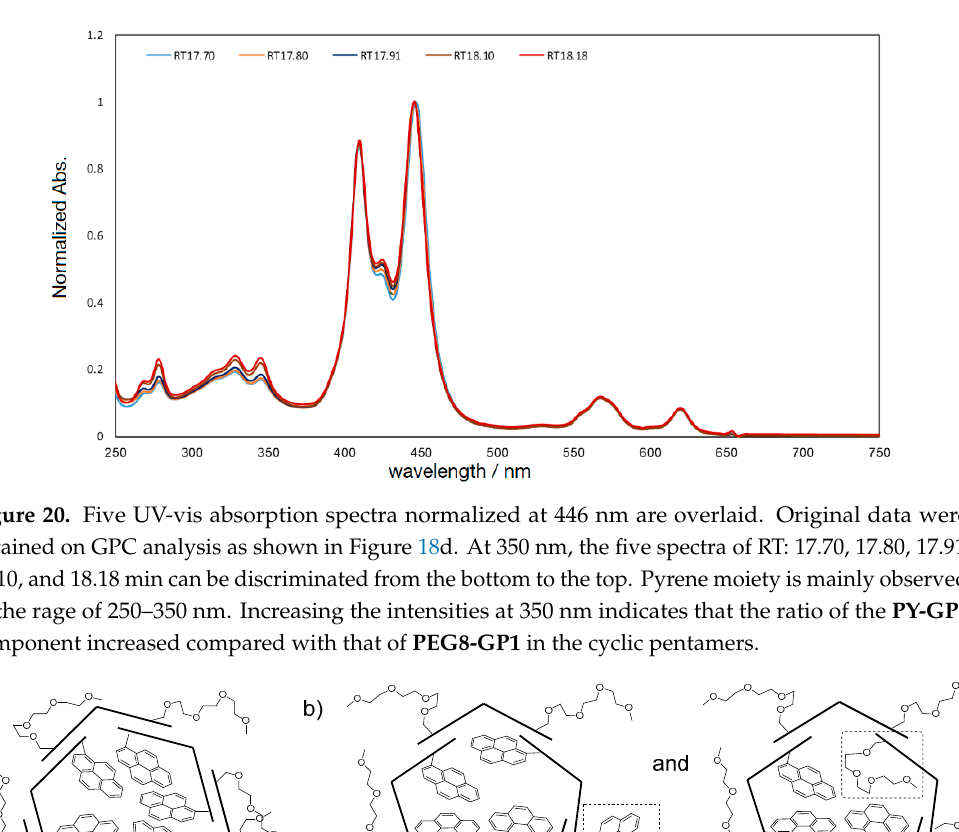
Figure 19. ( a ) UV-vis spectra of PY-GP1 and PEG8-GP1 overlaid before the peak maximum (17.8 min) in Figure 18d. ( b ) Overlaid after the peak maximum in Figure 18d. The maximum wavelength is constant at 446 nm in both ( a ) and ( b ).